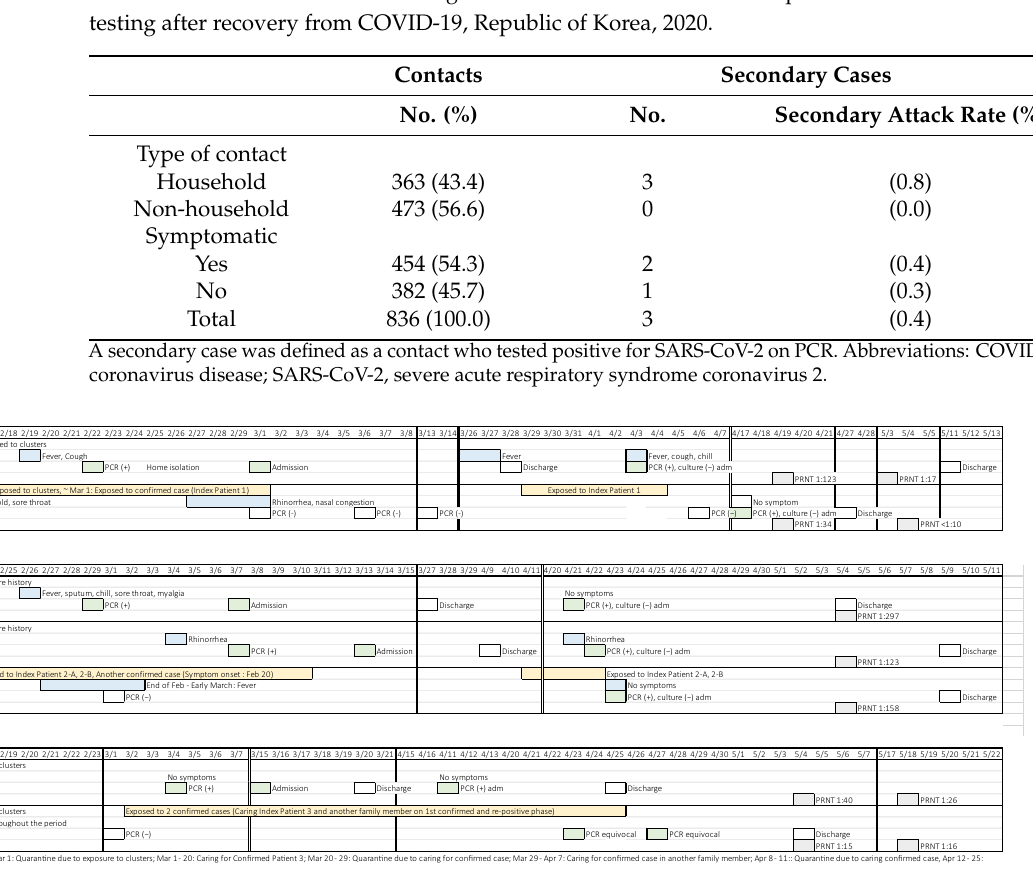
Figure 2. Case summary of secondary cases of SARS-CoV-2 positivity among contacts of patients with re-positive SARS- CoV-2. Abbreviations: Adm, admission; PCR, polymerase chain reaction; PRNT, plaque reduction neutralization test.